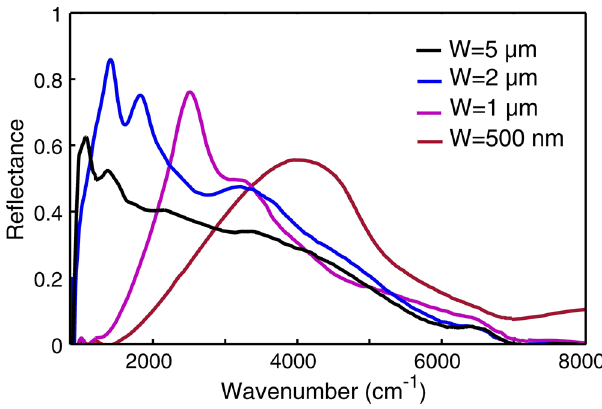
Fig. 2 Plasmonic re fl ectances obtained by removing both the sapphire phonon contributions below − 1000 cm − 1 and the high-frequency background above − 7000 cm − 1 . Plasmon absorption hardens by decreasing width W and periodicity 2W , i.e. by increasing the corresponding wavevector q = π / W as expected from theory.